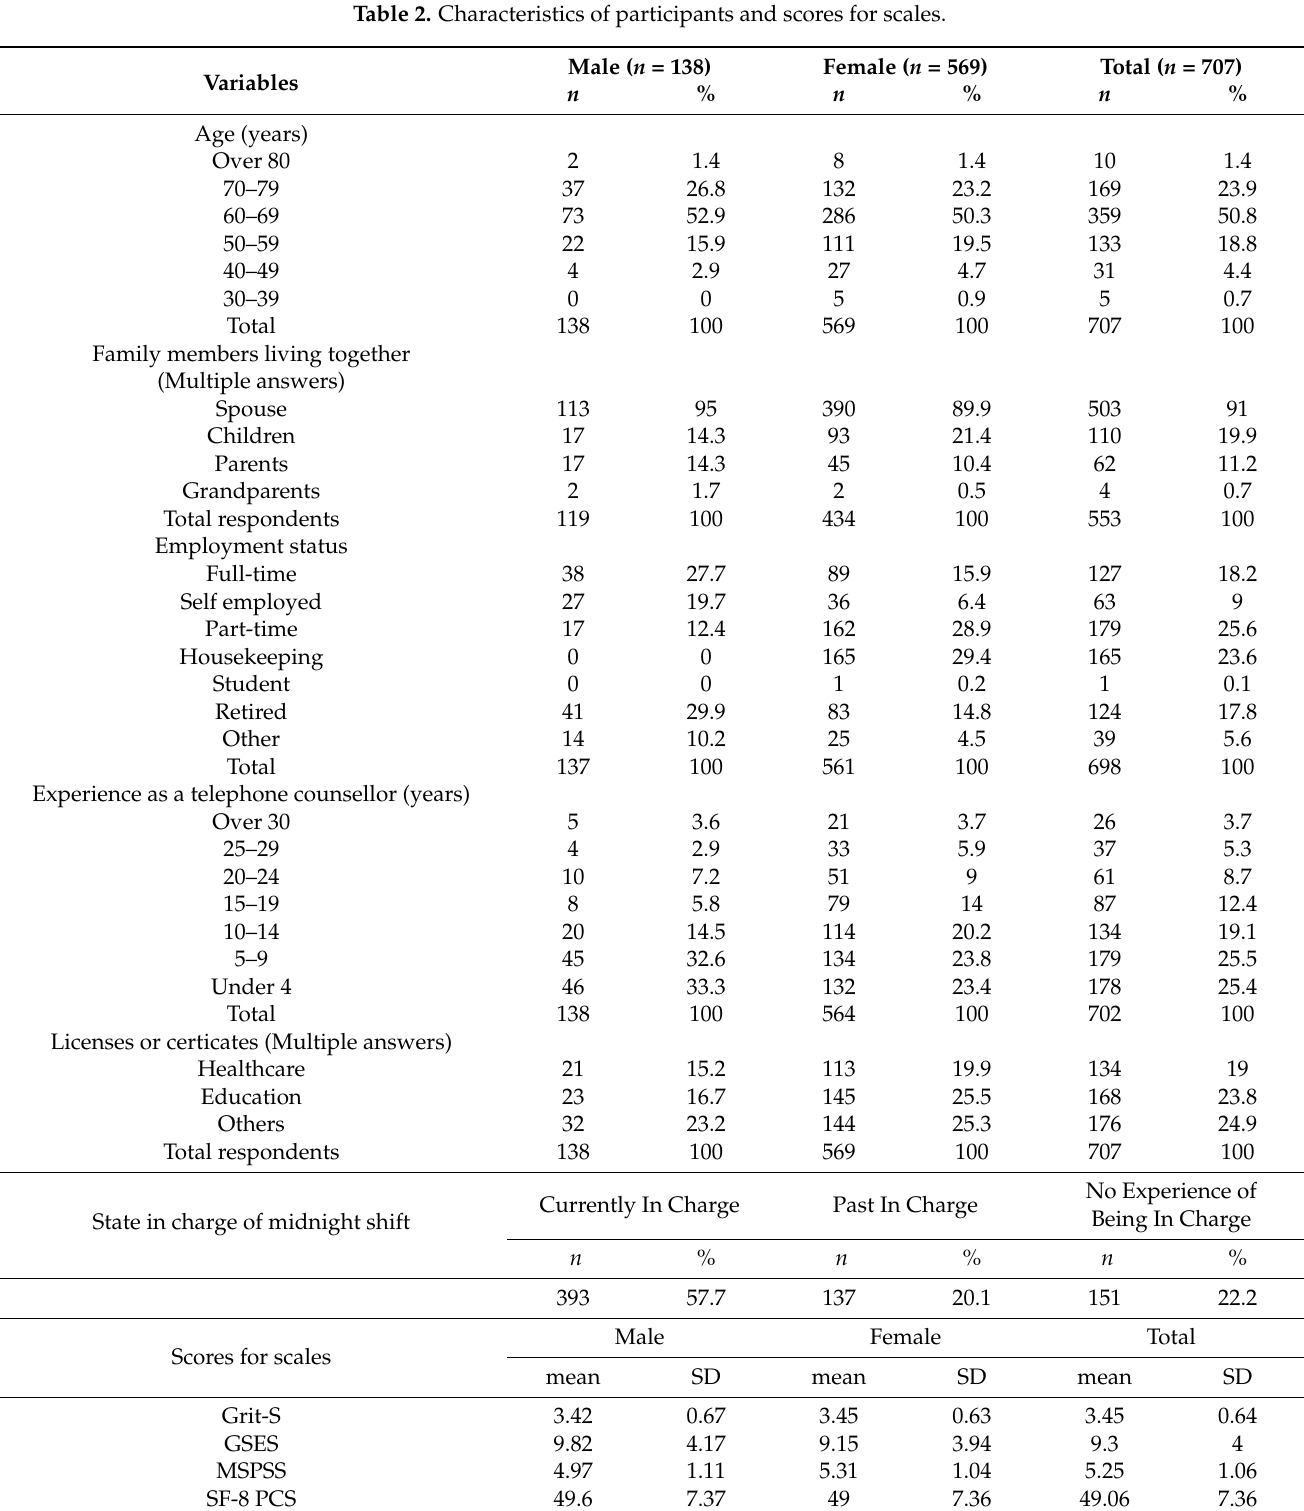
Table 2. Characteristics of participants and scores for